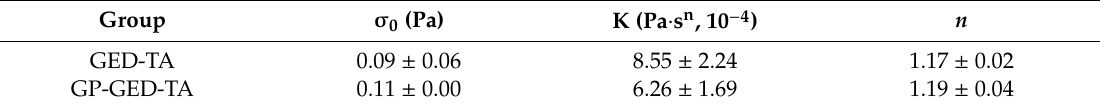
Table 1. Shear-rate dependence of viscosity for O / W emulsion data fitting by the Herschel–Bulkley model.